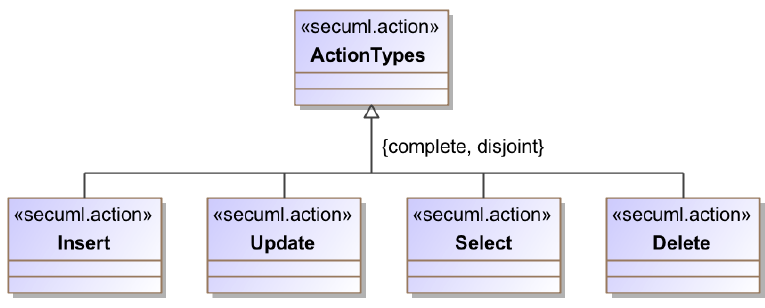
Figure 3. Action types for the security